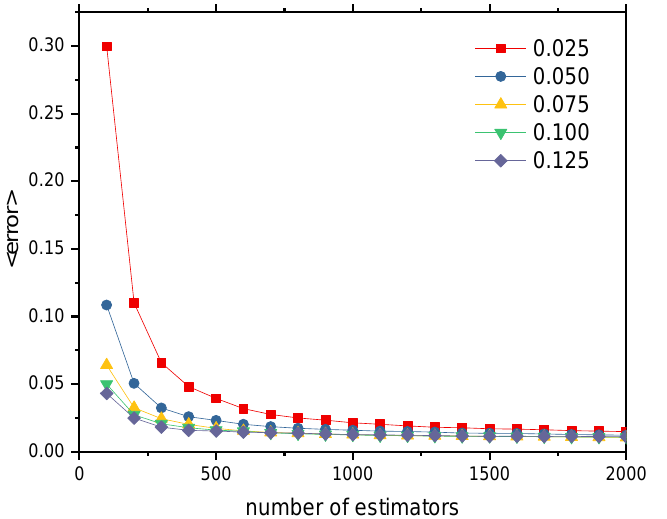
Figure 5. The average prediction errors versus the number of estimators curves for the different learning rate.